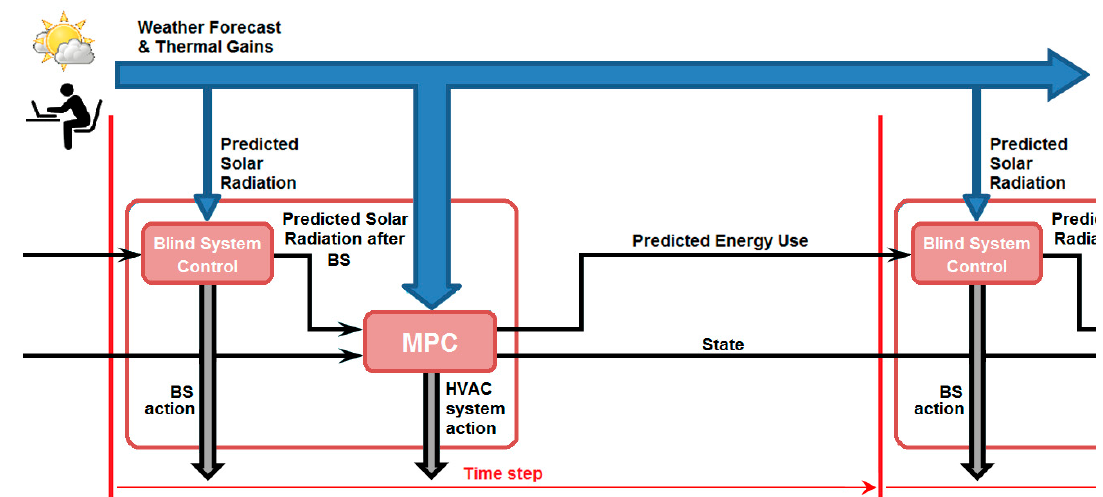
Figure 4. Scheme showing one of the interactions of the enhanced BSC with the main MPC control.